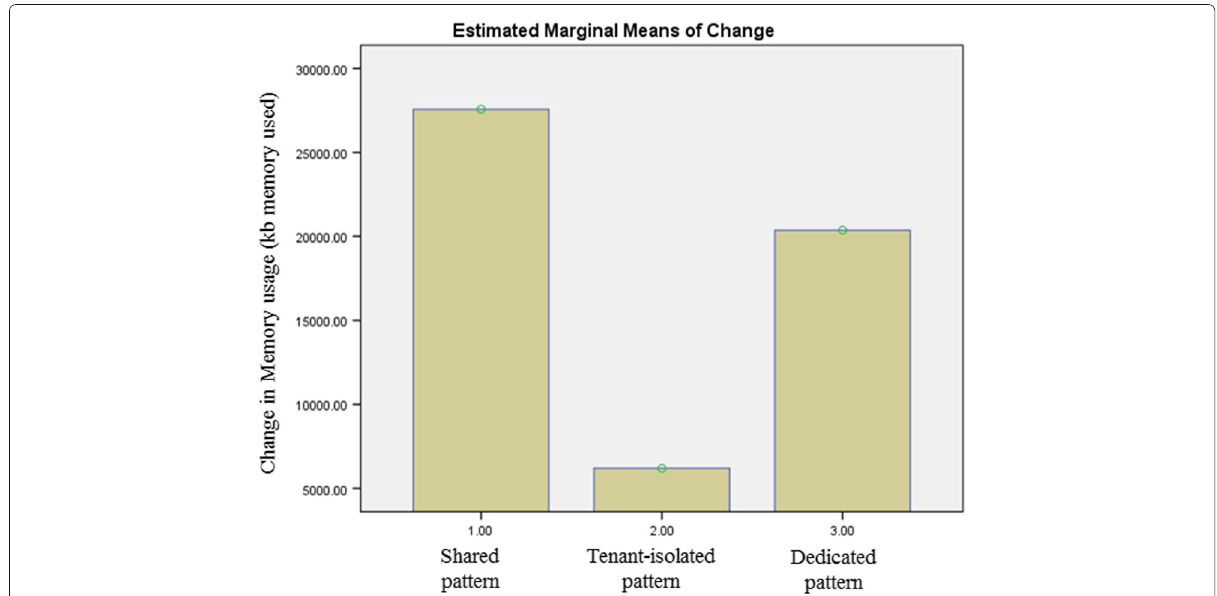
Fig. 19 Changes in Memory [CS2]